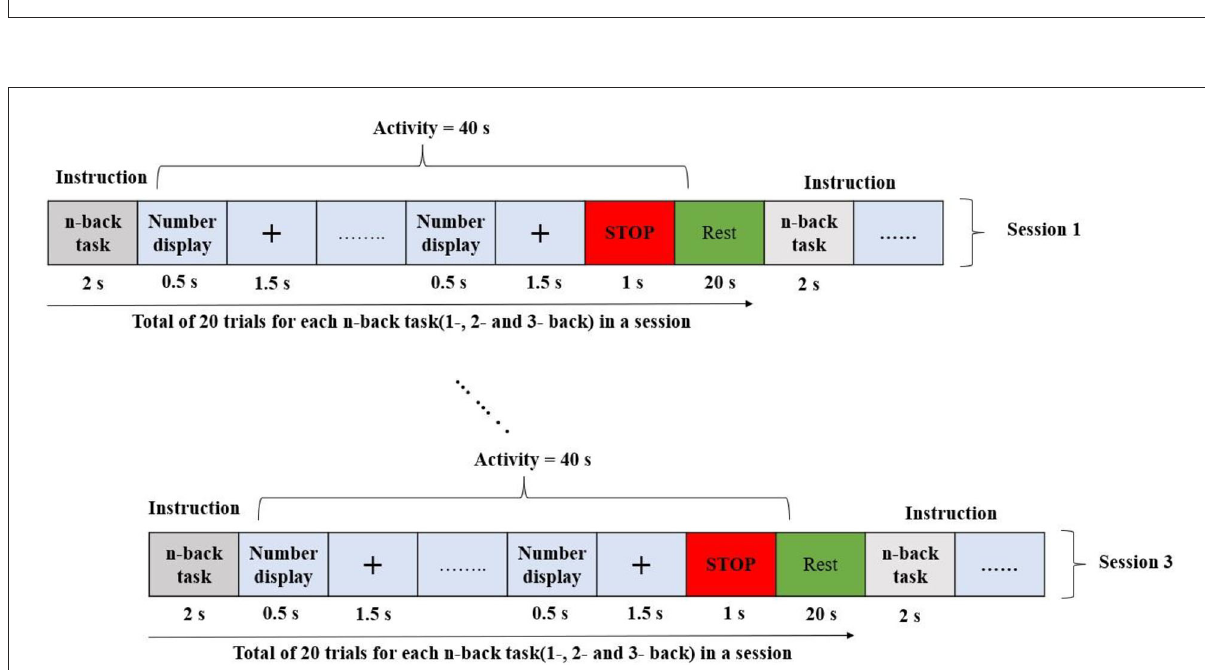
FIGURE2 Experiment paradigm of n-back tasks.